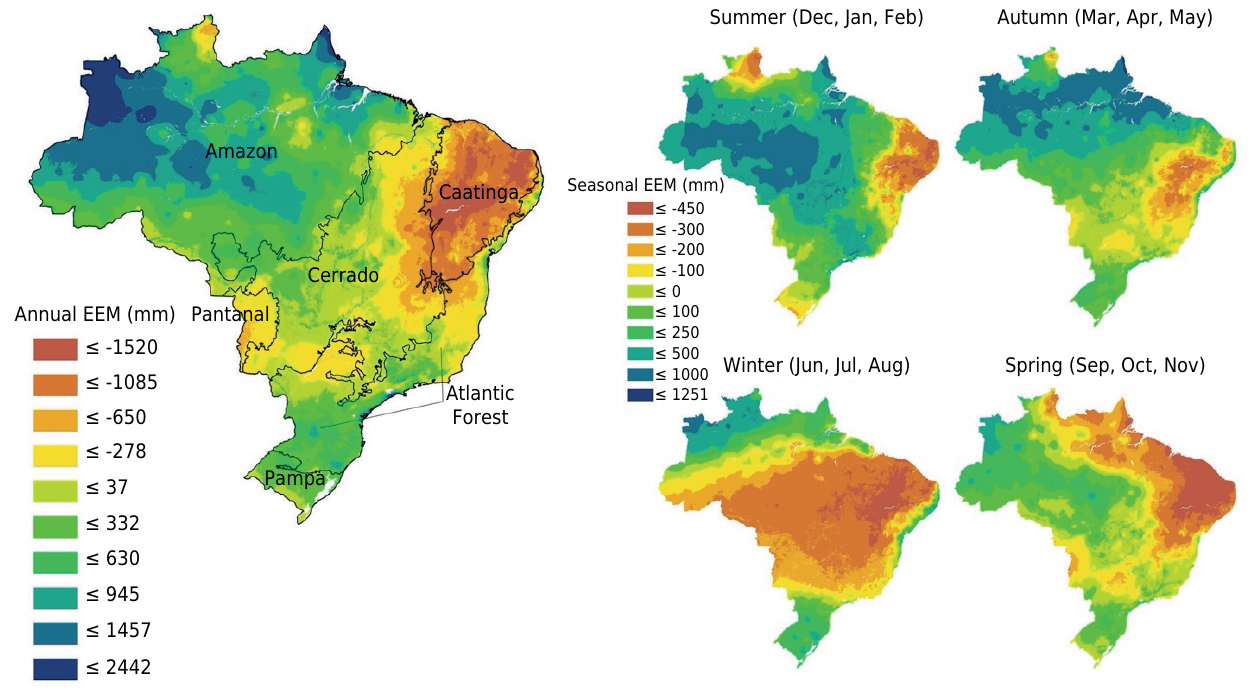
Figure 2. Spatial distribution of annual and seasonal ecosystem effective moisture (EEM), i.e., the difference between mean annual precipitation and potential evapotranspiration (Kramer and Chadwick, 2018) across the Brazilian territory. Summer: